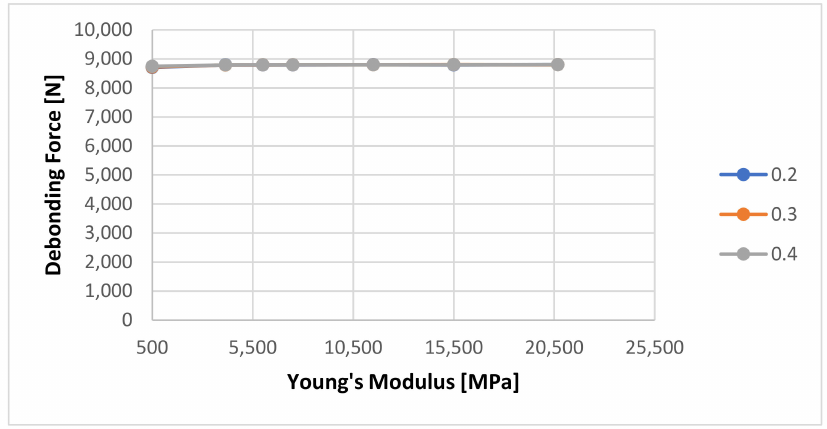
Figure 14. Calculated debonding force as a function of Young’s Modulus of the cement with a 1-day curing time, please note that all three lines are overlapping showing just one gray line.